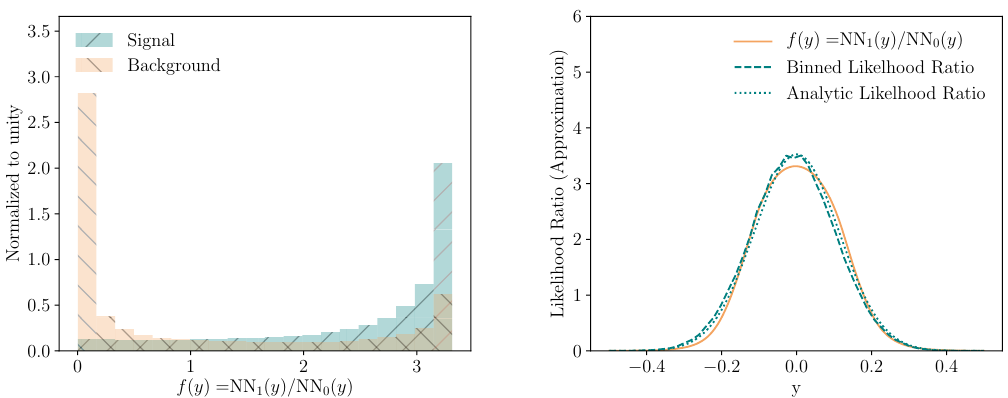
( y ) / NN ( y ) . Right: the functional form 1 2